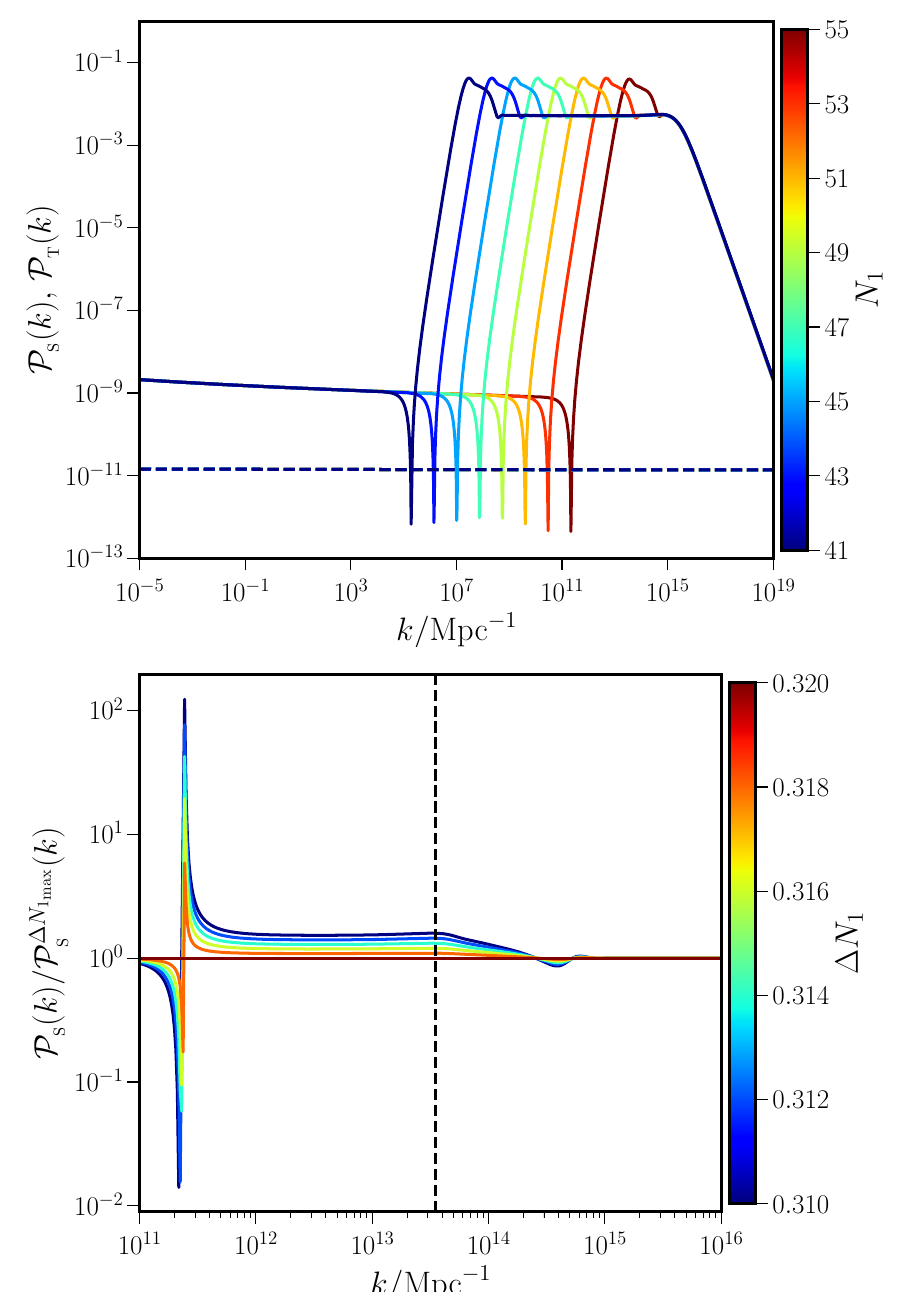
( k ) (in solid lines) and the tensor power spectra ( k ) (in Figure 5. The scalar power spectra P S P T dashed lines) that arise in the reconstructed scenario have been plotted for a range of N 1 (on top ) and ∆ N 1 (at the bottom ). It should be clear (from the figure on top) that, earlier the onset of ultra slow roll, broader is the peak in the scalar power spectra. Also, for the effects due to the variation in ∆ N 1 to be distinguishable, we have illustrated (in the figure at the bottom) the relative change in the scalar power spectrum with respect to the spectrum corresponding to the maximum value of ∆ N ∆ N 1 that we have considered (viz. 1 = 0.320). We have also indicated the wave number where the peak is located in the spectra (in dashed black). We find that, for a given value of N 1 (in this case, N 1 = 41), a reduction in ∆ N 1 leads to an increase in the amplitude of power over the range containing the rise and the peak in the